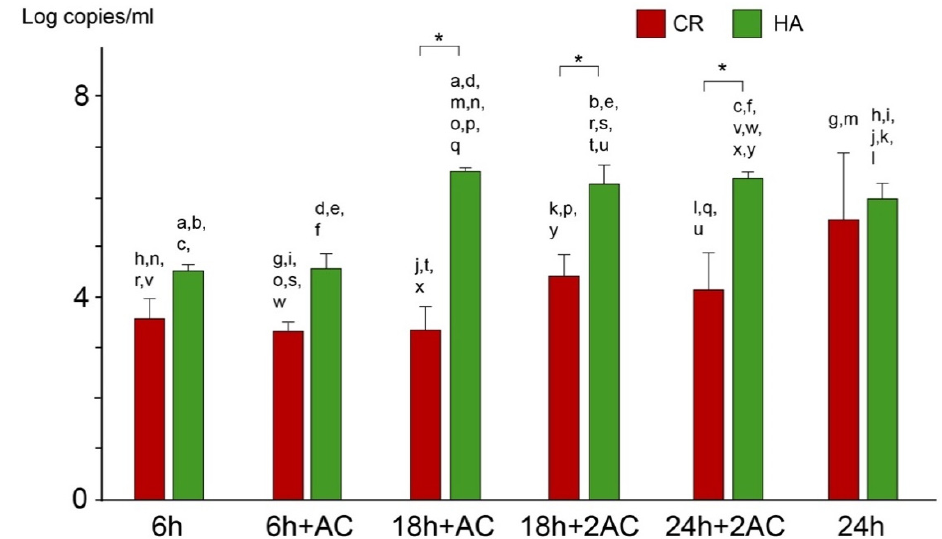
Figure 5. Total bacterial counts of S. mutans biofilm cells after incubation at each defined time as determined by colony counts. The results are shown as means ± the SD of 5 replicates. Pairs of the same scripts represent significant differences ( p < 0.05). * p < 0.05. 6 h: 6 h of culture; 6 h + AC: A single exposure to 1M acetic acid (pH 4.5) for 30 min after 6 h of incubation; 18 h + AC: The specimen was exposed to the acidic solution after 6 h of incubation and then cultured up to 18 h; 18 h + 2AC: A second exposure of acetic acid after 18 h of incubation; 24 h: 24 h of culture without acidic treatment; 24 h + 2AC: The specimen was exposed to acidic solution after 6 h and 18 h of incubation during 24 h of culture. CR: Caredyne Restore; HA: hydroxyapatite; AC: acid challenge; AC2: acid challenge twice.